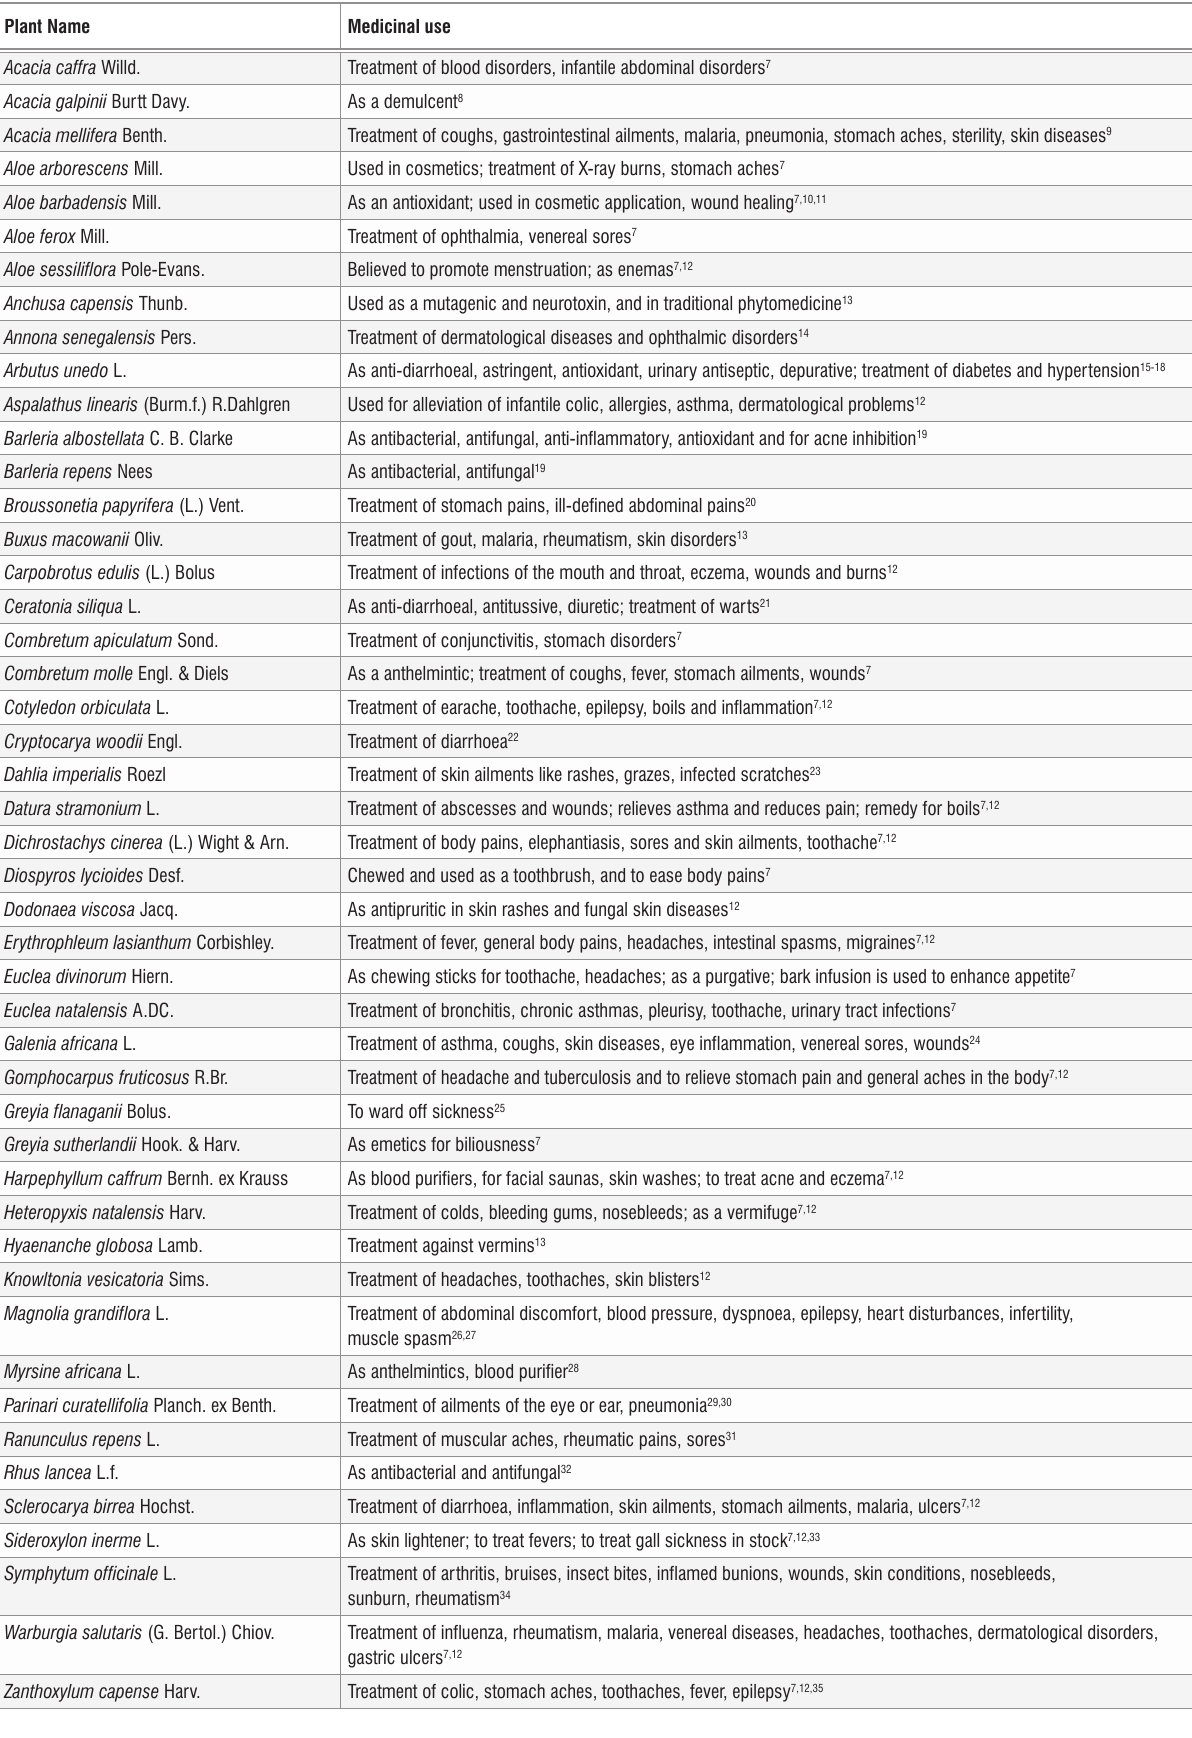
Table 1: Medicinal use of plants selected for present